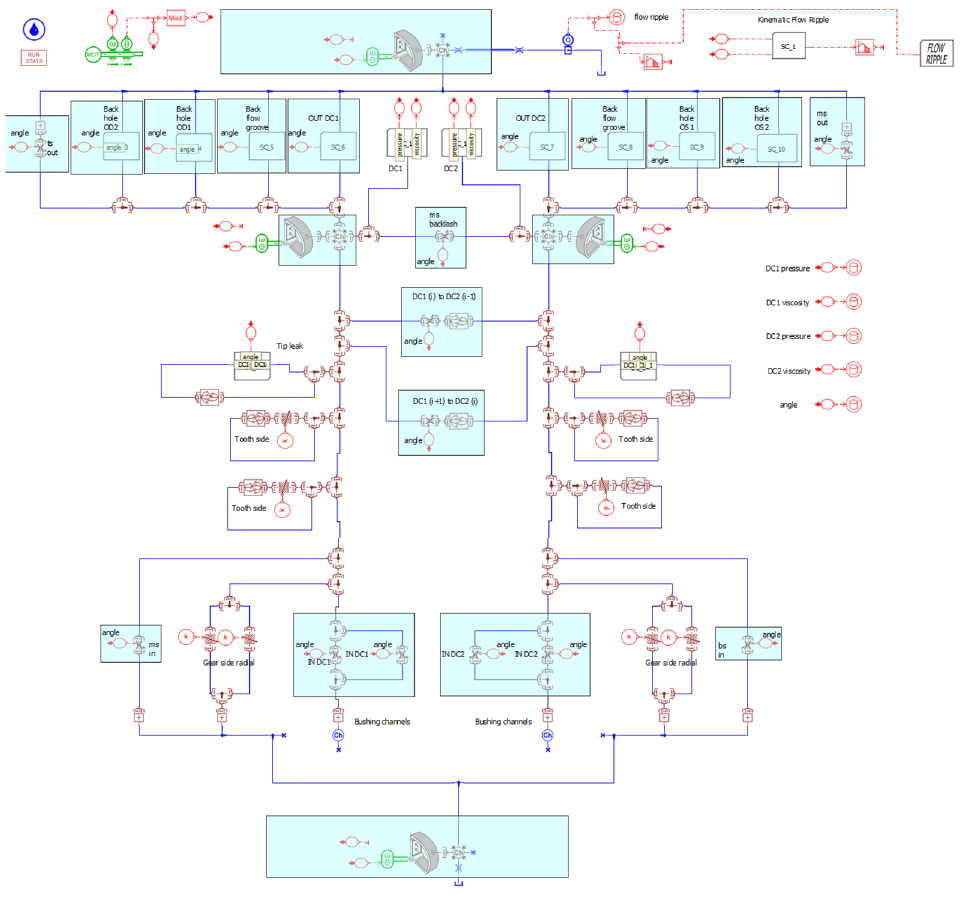
Figure 7. Hydraulic simulation model overview.